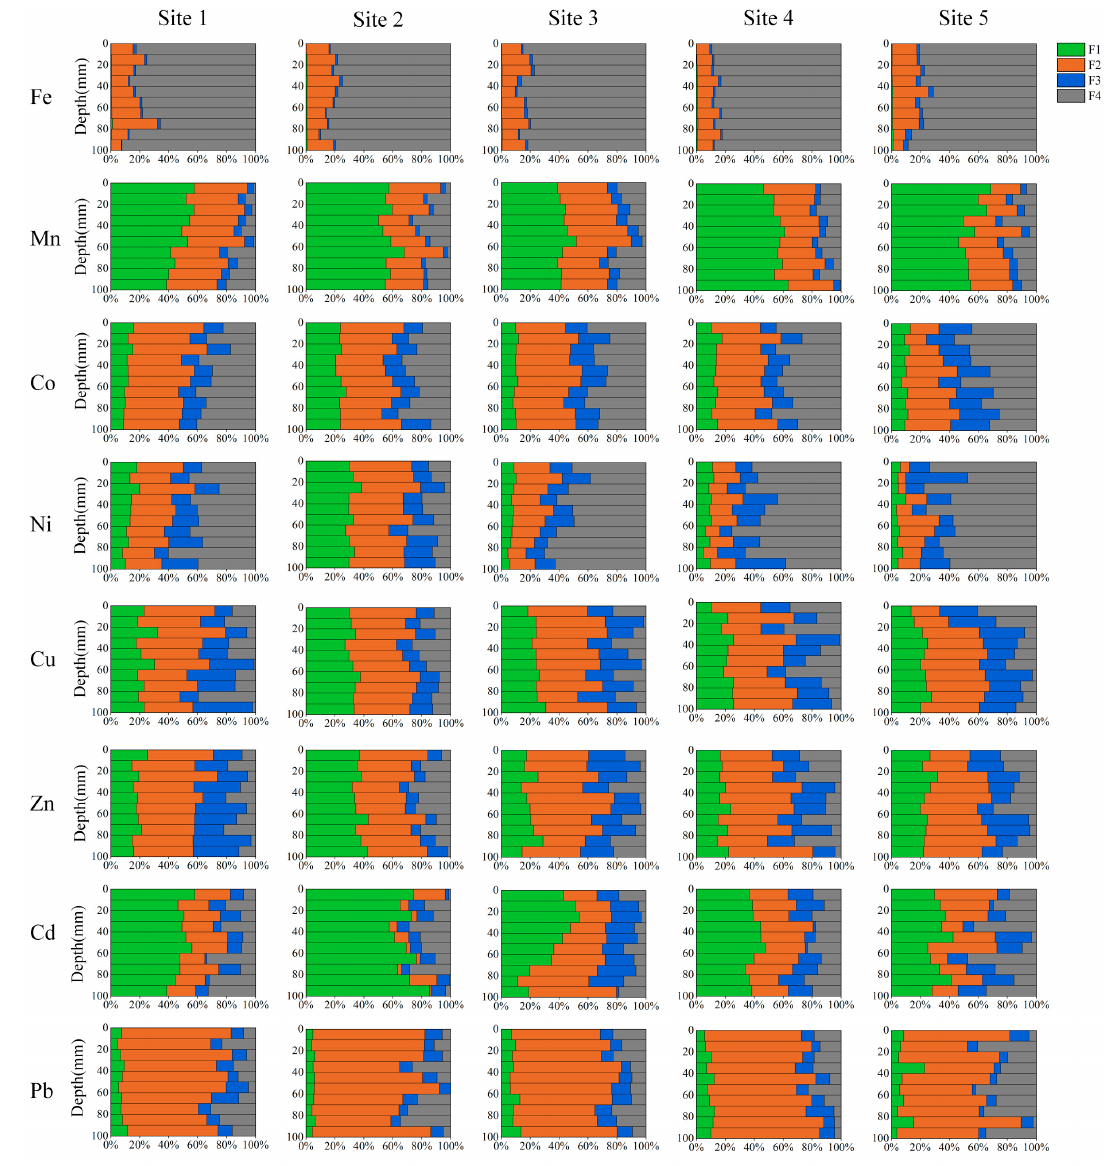
Figure 4. Speciation of metals in sediments based on a modified BCR scheme. The four forms are water and acid soluble (F1), reducible (F2), oxidisable (F3), and residual form (F4), respectively.